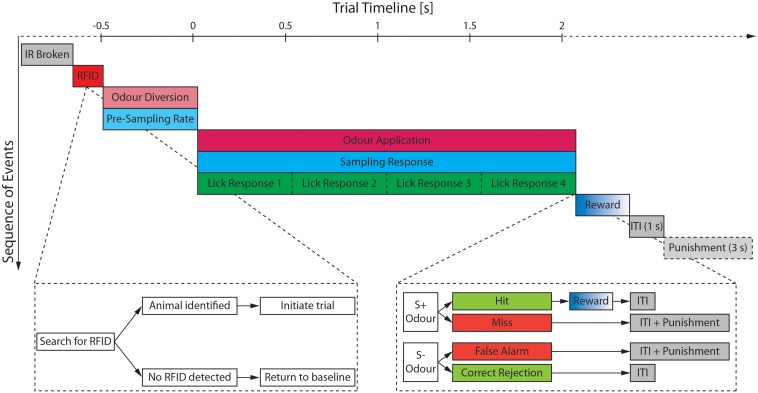
Schematic of the trial structure and the most relevant monitored parameters. After a break of the IR beam has been detected (gray), the search for an RFID signal is started (red). Once an animal has been detected and identified the trial is initiated starting with an initial 500 ms period during which the airstream is diverted through the odor reservoirs (light magenta) and the pre-sampling rate (light cyan) is measured. If the pre-sampling rate surpasses the defined threshold, the final valve opens and the odor is applied (magenta) for maximally 2 s unless the animal retracts its head from the odor port before the 2 s have elapsed. During the odor application both the sampling rate (cyan) as well as the lick response (green) of the animal are monitored. The water reward (blue) is only delivered upon correct identification of a S+ odor (=Hit) followed by a mandatory inter-trial interval (ITI; gray) of 1 s. Any false response to an odor (=Miss or False Alarm) incurs an additional time penalty of 3 s increasing the ITI to 4 s. Time is shown relative to opening of the final valve.